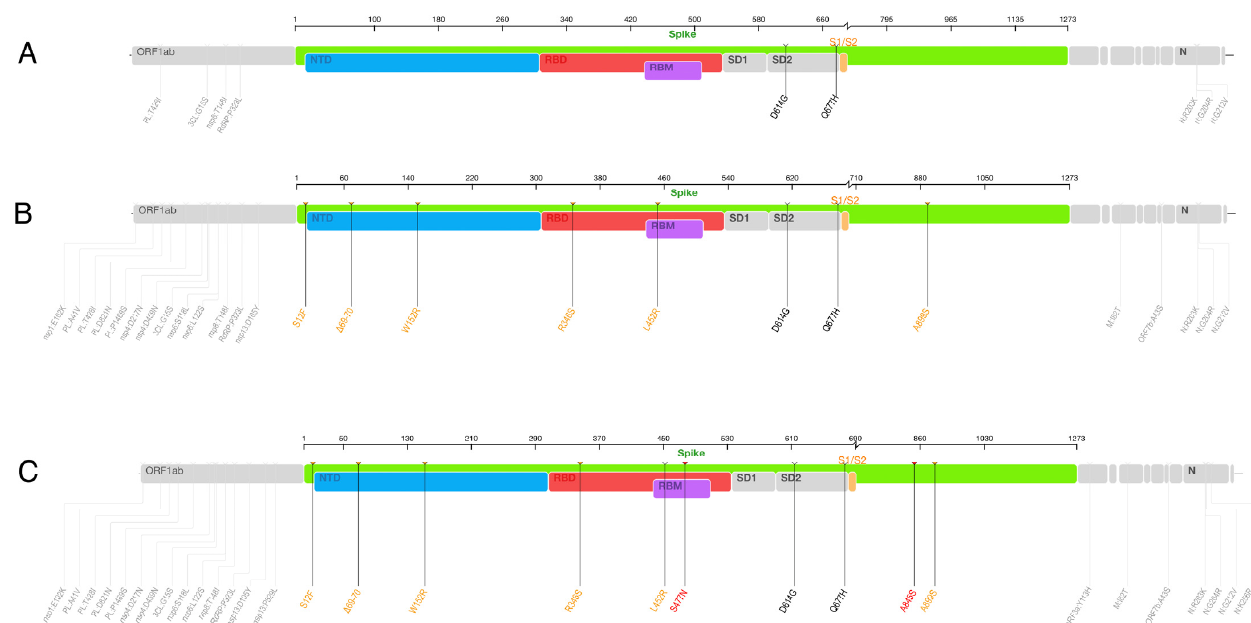
Figure 4. Genomic maps showing lineage defining mutations of the C.36 lineages. ( A ) Lineage defining mutations of the C.36 lineage, ( B ) lineage defining mutations of the C.36.3 sub-lineage, and ( C ) lineage defining mutations in the C.36.3.1 sub-lineage. Additional Spike gene mutations in the C.36.3 lineage ( n = 6) are annotated in orange and mutations unique to C.36.3.1 ( n = 2) in red.